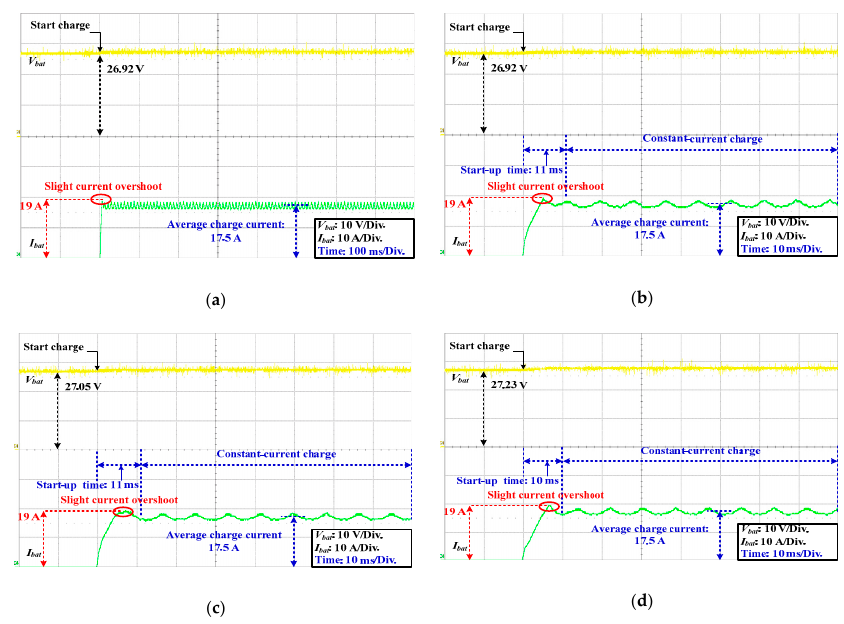
Figure 25. Using PSPI control. ( a ) Start-charge voltage: 26.92 V, SOC: 30%, time scale: 100 ms/div. ( b ) Start-charge voltage: 26.92 V, SOC: 30%, time scale: 10 ms/div. ( c ) Start-charge voltage: 27.05 V, SOC: 50%, time scale: 10 ms/div. ( d ) Start-charge voltage: 27.23 V, SOC: 70%, time scale: 10 ms/div.